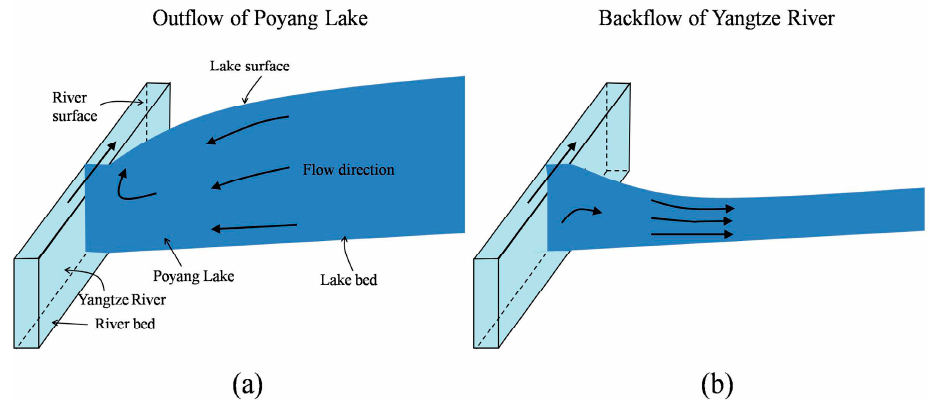
Figure 4. Diagram of interactions between the Yangtze River and Poyang Lake. The outflow of Poyang Lake water/sediments occurs during most of the year, but in contrast, the backflow of Yangtze River occurs only occasionally, mainly in summer. The blocking effect of the Yangtze River increases with the difference between river and lake levels, and ( b ) shows a stronger blocking effect than ( a ).